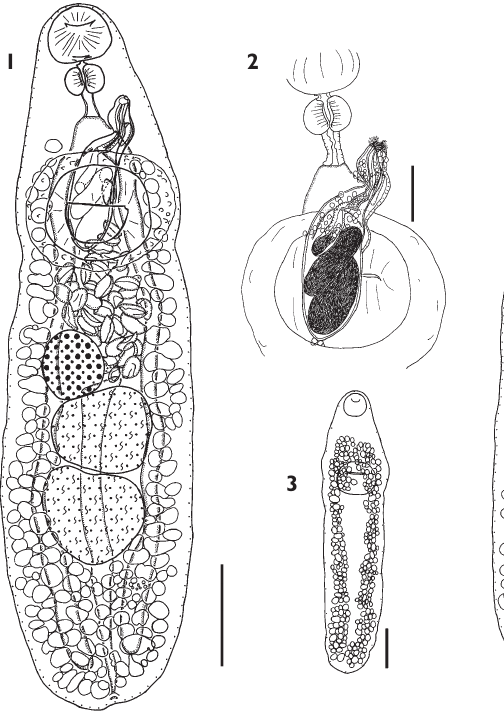
Figs 1-3. Macvicaria shotteri n. sp. ex Apogon fas- ciatus . 1. Whole-mount ventral view. 2. Terminal genitalia. 3. Dorsal distribution of vitelline folli- cles. Scale bars : 1, 3, 250 μm; 2, 100